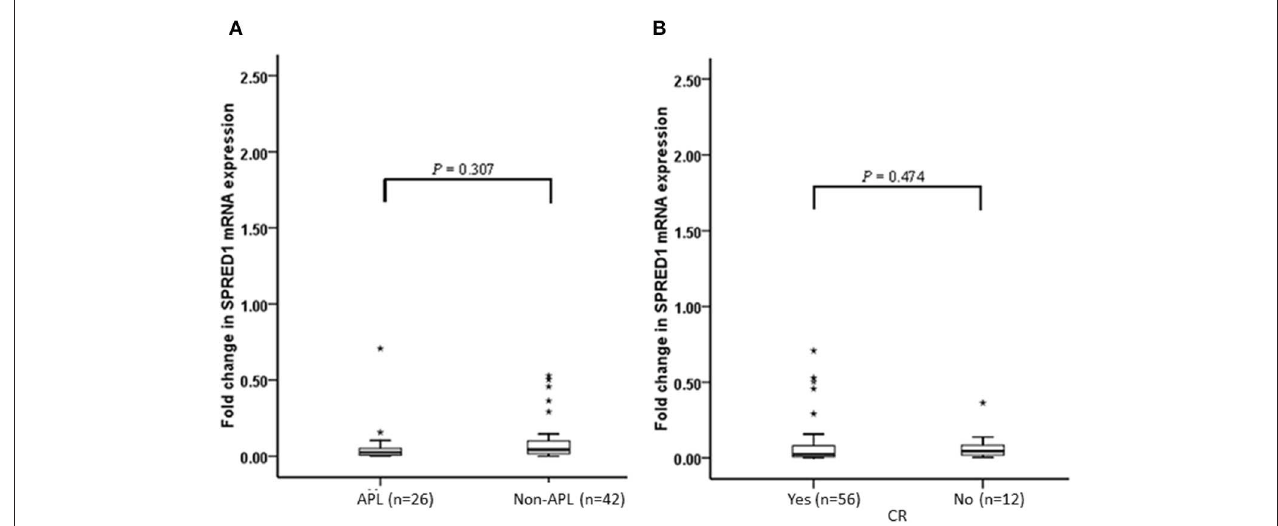
FIGURE 4 | Fold change of SPRED1 mRNA expression in AML patients at follow-up. Fold change in AML patients (Wilcoxon tests); (A) with APL and without APL; (B) with and without CR (Wilcoxon tests).